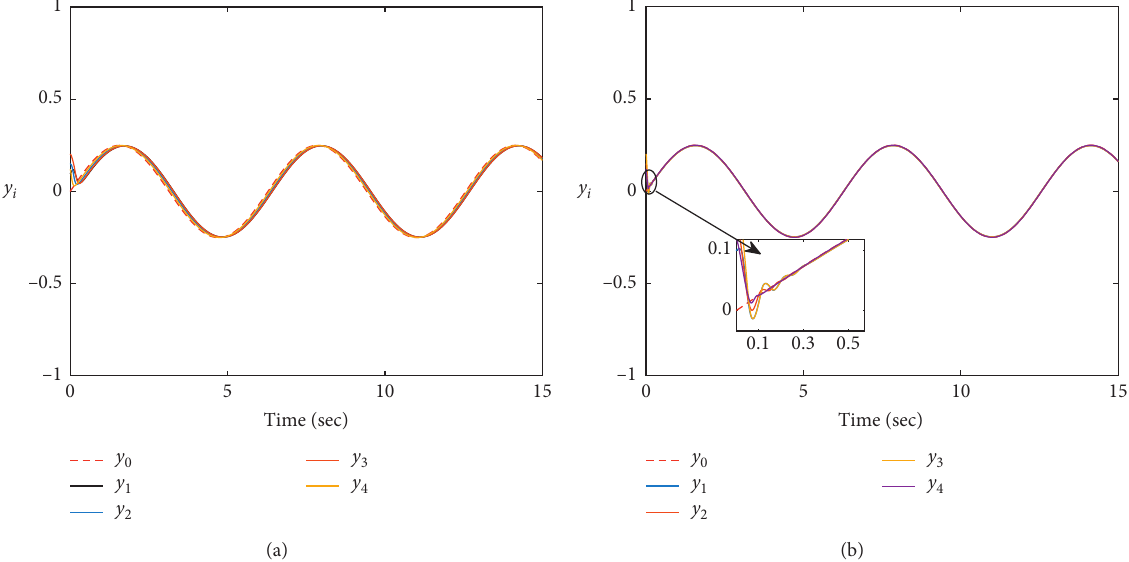
Figure 6: Output trajectories of the followers with one leader by using two methods. (a) Output trajectories by the method in [36]. (b) Output trajectories by our method.